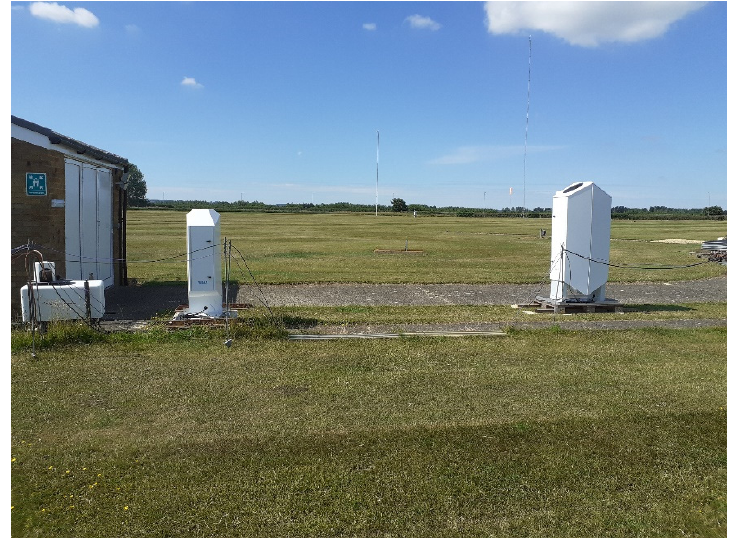
Figure 1. Vaisala BB-DIAL (on the right) installed at Met Office, Cardington, Bedfordshire, UK (14